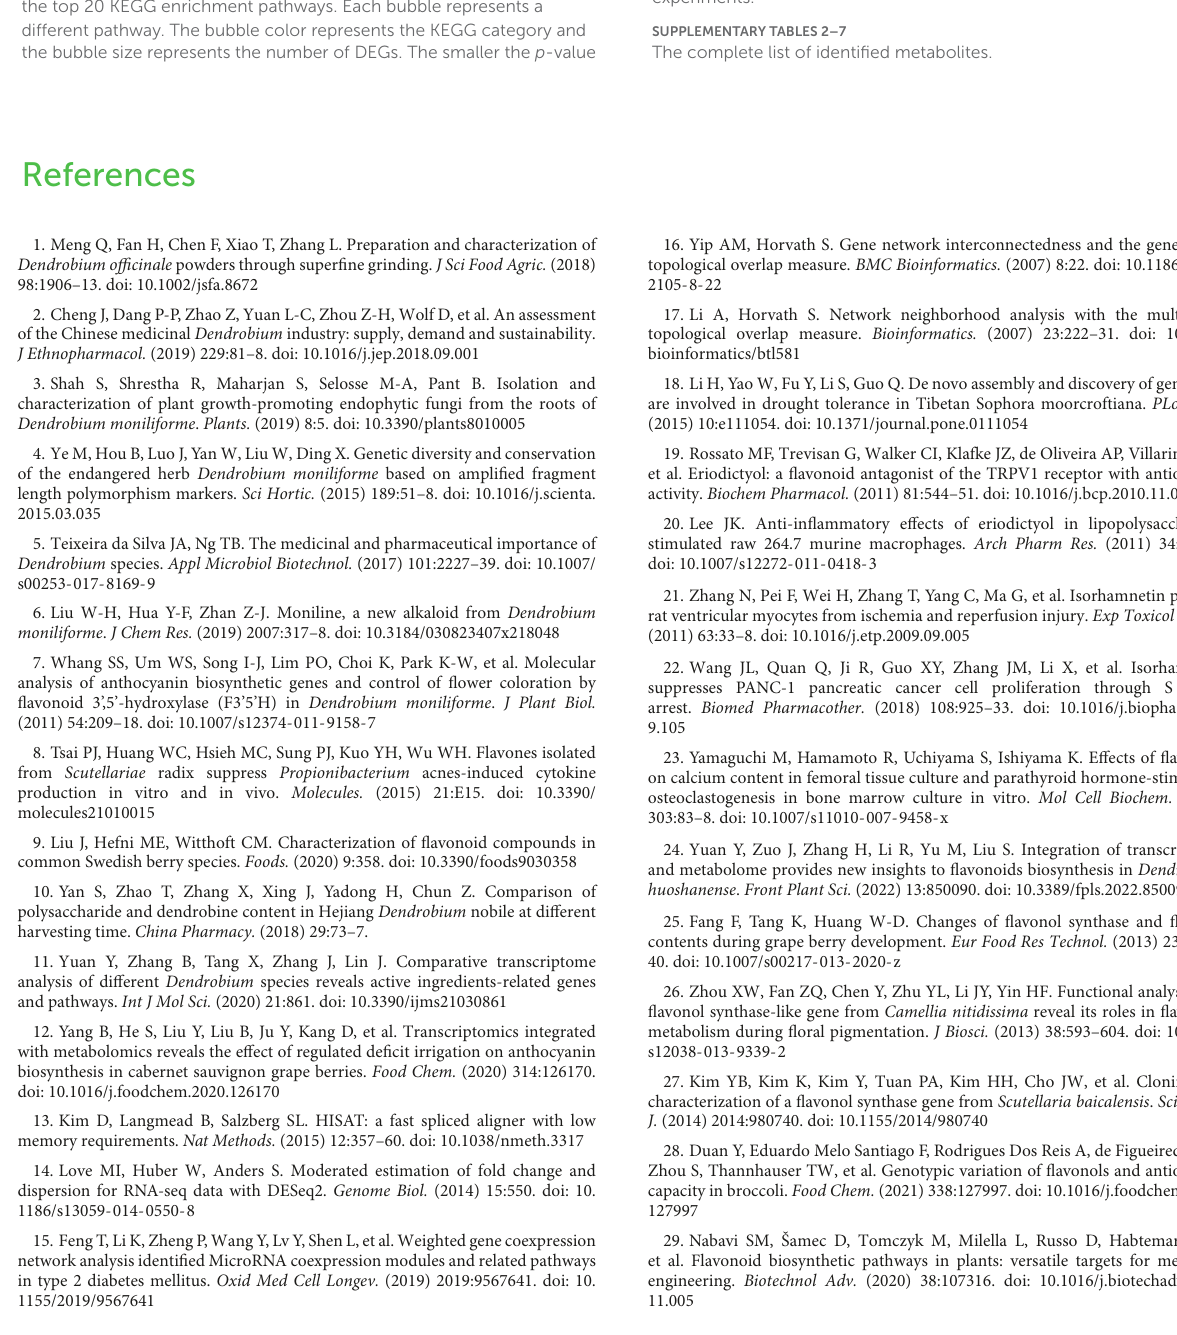
SUPPLEMENTARYFIGURE6 GO enrichment circle diagram. The outermost circle indicates the GO term, and different colors represent different subcategories; the second circle indicates the number and P -value of that GO term. The more genes the longer the bar, the smaller the value the redder the color; the third circle indicates the number of up- and down-regulated genes of the GO term, red indicates up-regulation and green indicates down-regulation. The fourth circle indicates the Rich Factor value of each classification. (A) 1Dm vs. 2Dm volcano; (B) 1Dm vs. 3Dm; (C) 1Dm vs. 4Dm; (D) 2Dm vs. 3Dm; (E) 2Dm vs. 4Dm; (F) 3Dm vs. 4Dm. SUPPLEMENTARYFIGURE7 KEGG pathway enrichment bubble diagram. The bubble diagram shows the top 20 KEGG enrichment pathways. Each bubble represents a different pathway. The bubble color represents the KEGG category and the bubble size represents the number of DEGs. The smaller the p -value